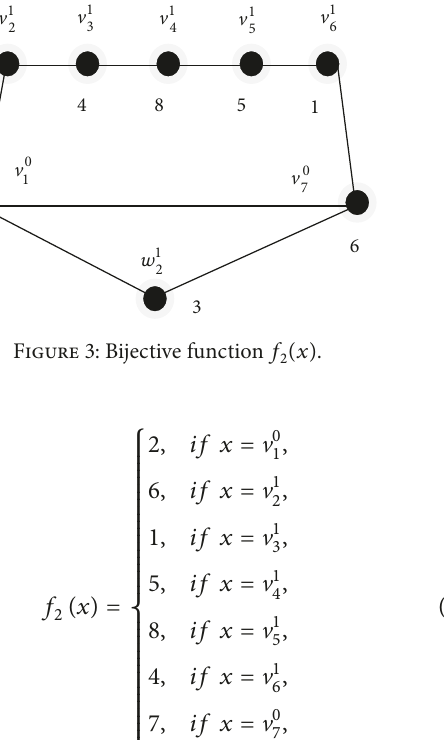
Figure 5: Bijective function 𝑓 4 (𝑥)